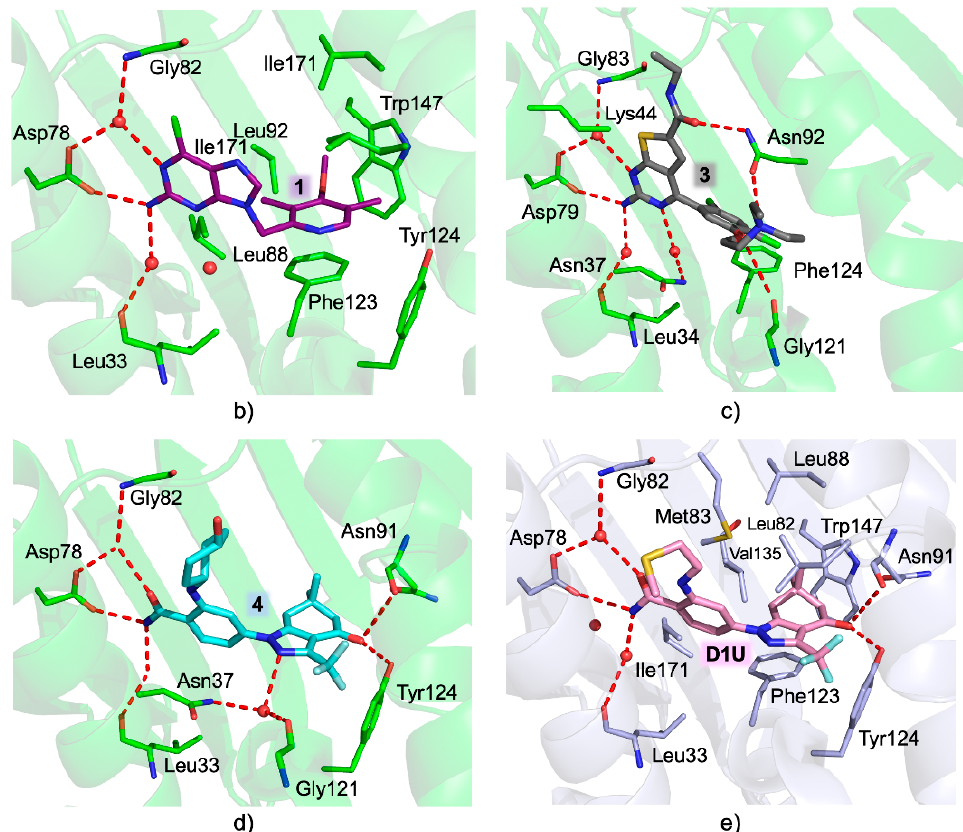
Figure 17. ( a ) Chemical structures of compounds 1, 3, 4 [67], and D1U. Active-site view of ( b – d ) Tb -NTD (green cartoon and carbons) in complex with ( b ) compound 1 (in sticks, dark purple carbons; PDB id 3O6O [67]), ( c ) compound 3 (in sticks, grey carbons; PDB id 3OMU [67]), and ( d ) compound 4 (in sticks, aquamarine carbons; PDB id 3OPD [67]); ( e ) Lm -NTD (light blue cartoon and carbons) in complex with D1U (in sticks, pink carbons; PDB id 3Q5K, unpublished results). Sulfur atoms are colored yellow, chlorine light green, and fluorine light cyan.